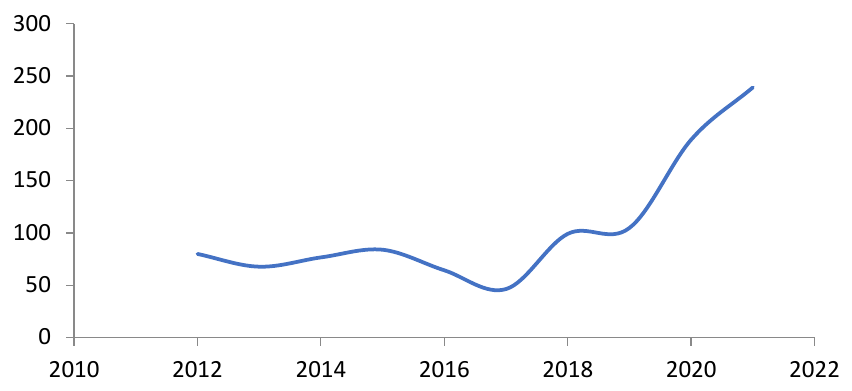
Figure 2. The graph illustrates the growing volume of CO 2 emissions trading on the voluntary market according to the Ecosystem Marketplace. The data are given in million tons eq CO 2 .